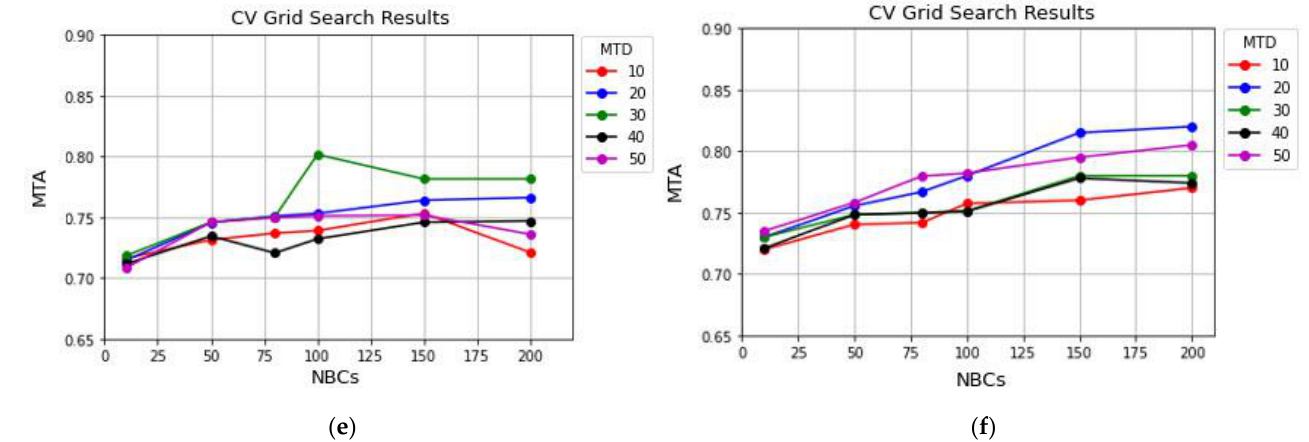
Figure 13. Hyper-parameter analysis of different EL methods using San Francisco PolSAR dataset. ( a ) DT, ( b ) AdaBoost, ( c ) GBM, ( d ) XGBoost, ( e ) LightGBM, and ( f ) RF.